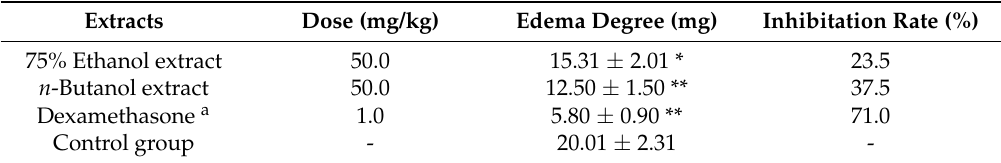
Table 2. Effects of the plant extracts on ear edema induced by croton oil in mice.